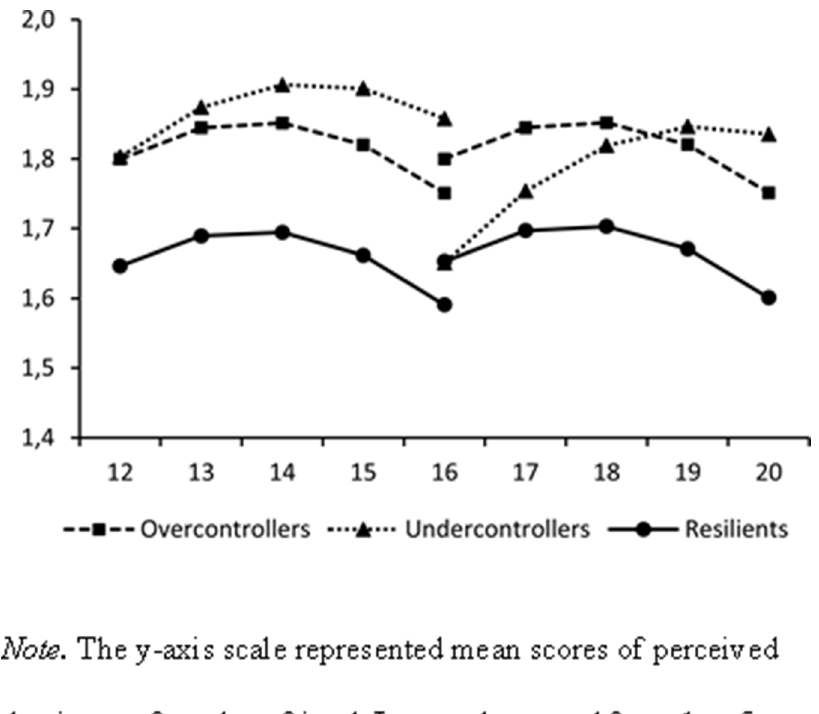
Figure 4. Estimated Developmental Changes in Adolescents’ Perceived Dominance from Best Friend by Adolescent Personality